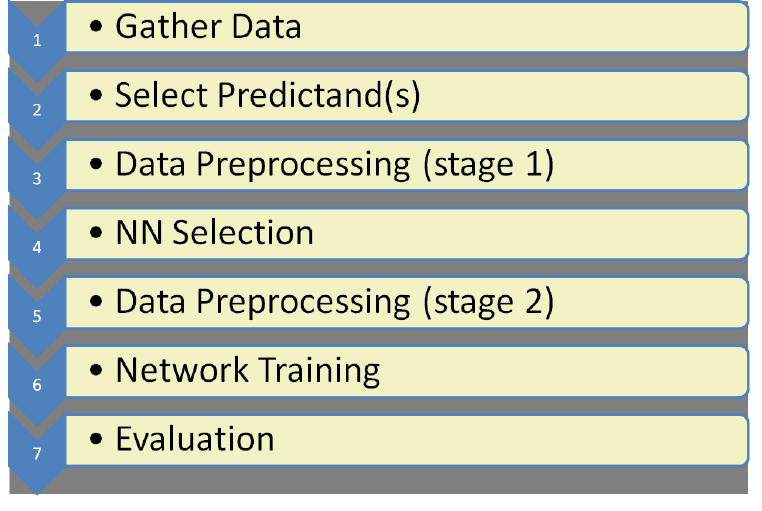
Figure 6. Framework outlined by Dawson and Wilby [34] for the application of NNs to rainfall-runoff modelling and flood forecasting, which will be applied in the context of our